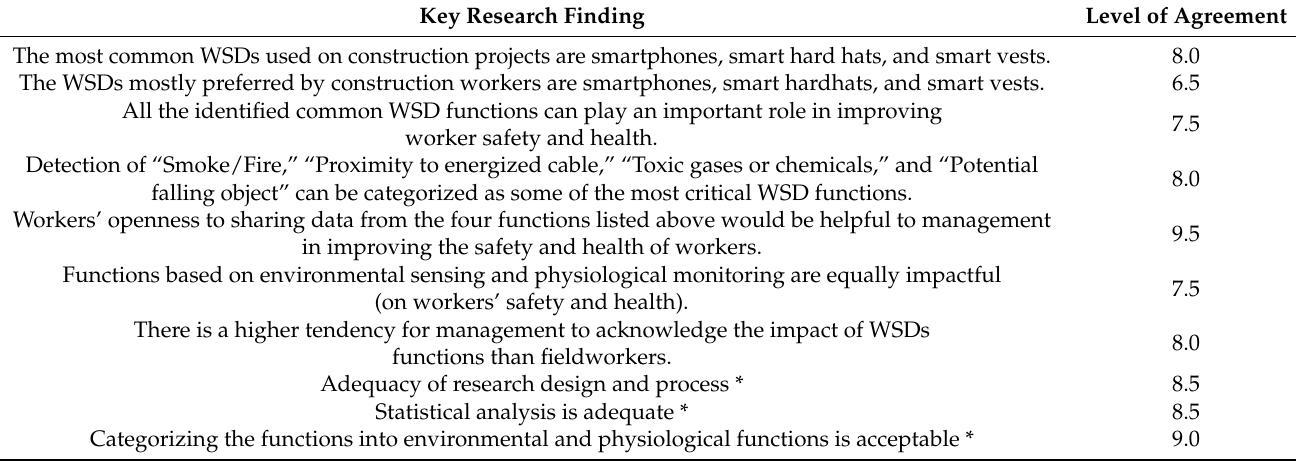
Table 6. Research outcome assessment.